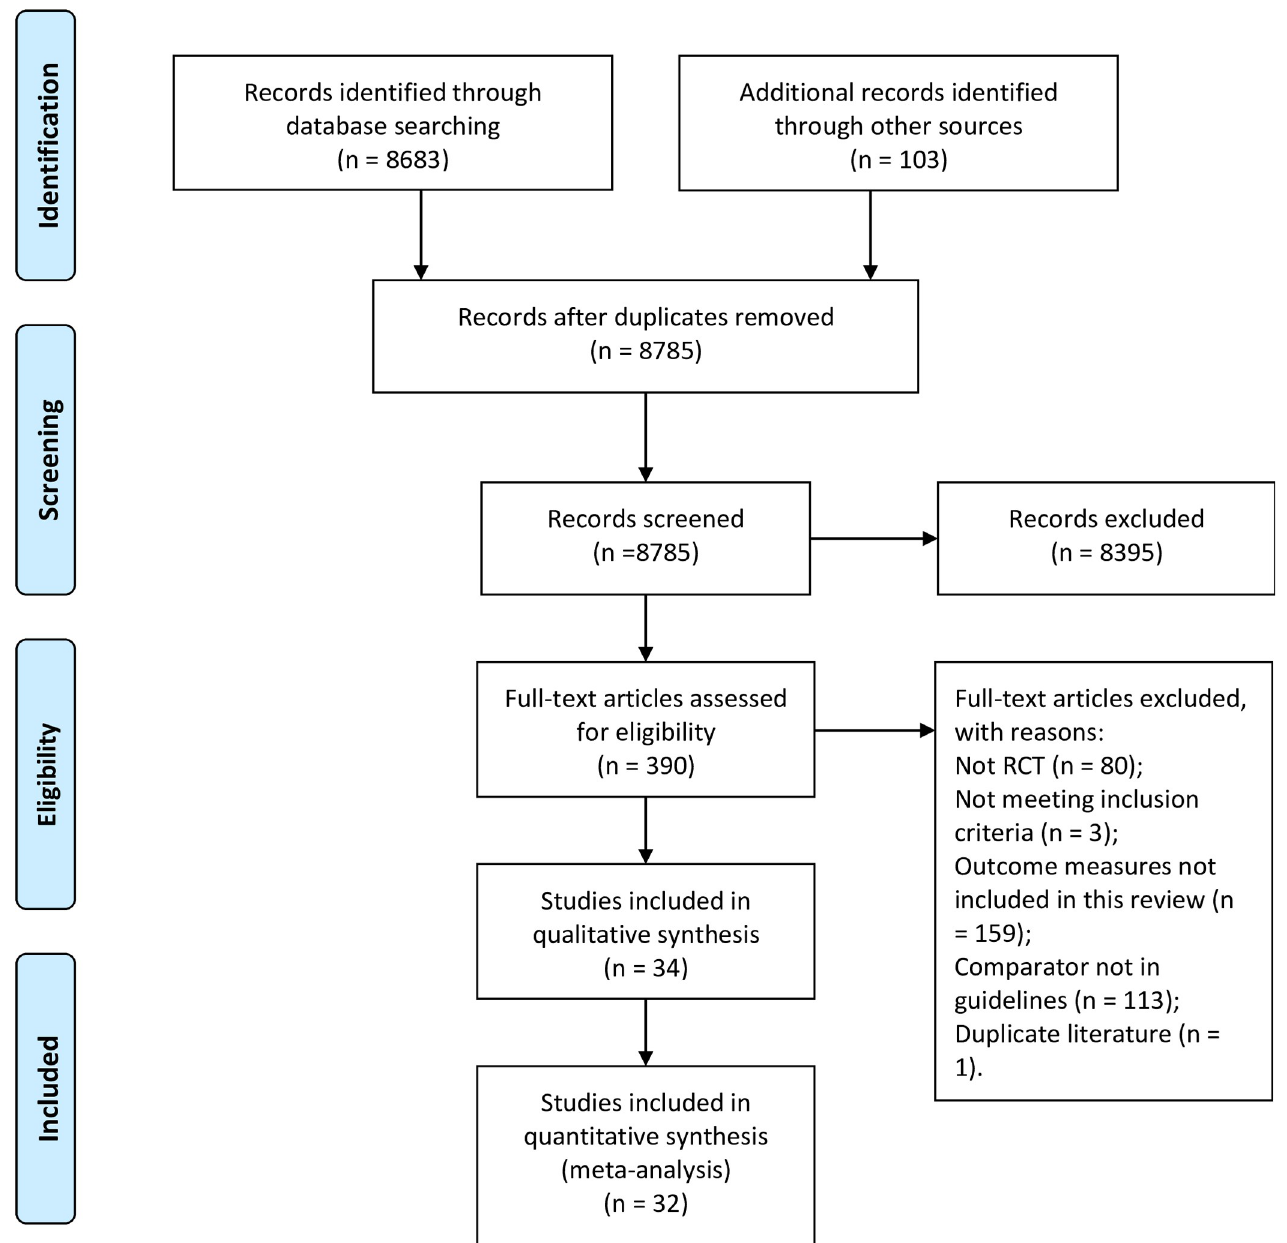
Fig 1. Flow diagram of search and selection process for studies of CHM for RS. Abbreviations: CHM: Chinese herbal medicine; RCT: randomized controlled trial; RS: rhinosinusitis.